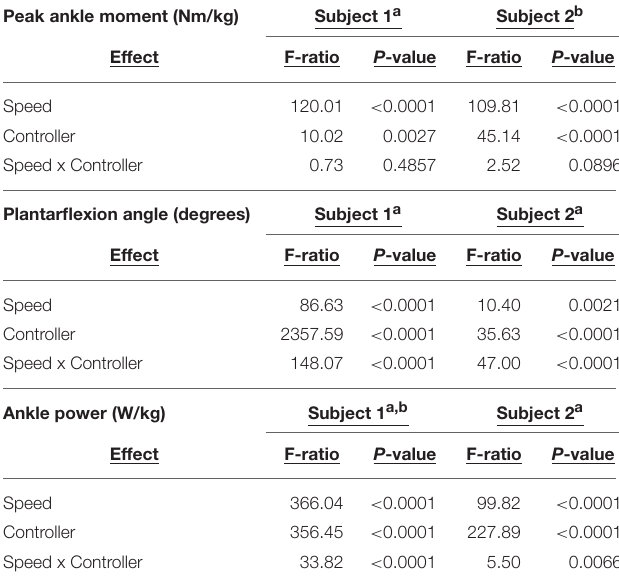
TABLE 3 | Peak sagittal plane ankle moment, plantarflexion angle, and ankle power for two subjects during level walking at variable speed. Peak ankle moment (Nm/kg)